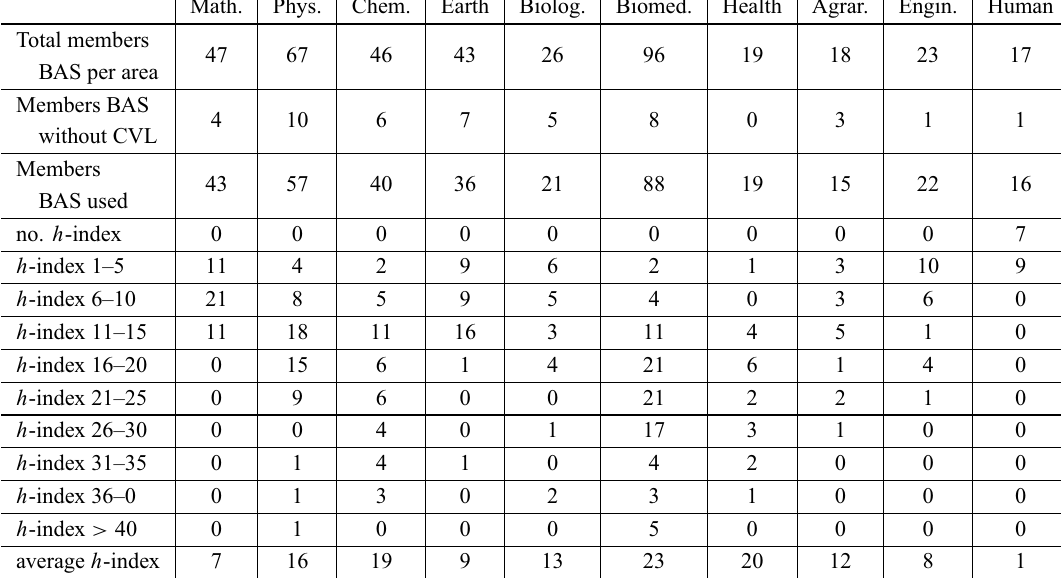
H -indexes of the members of the 10 categories of the Brazilian Academy of Sciences. Math. Phys. Chem. Earth Biolog.